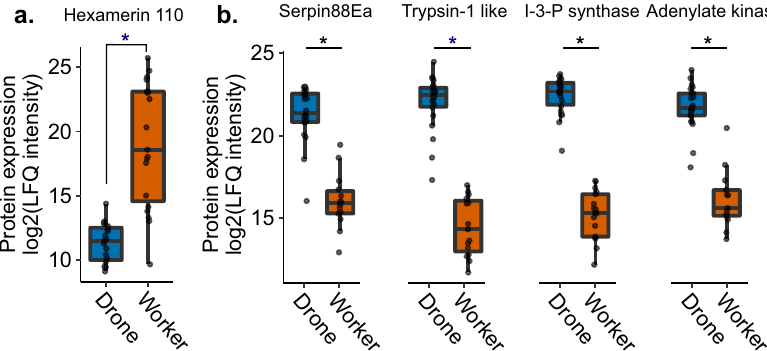
Fig. 5 Expression of the top fi ve most strongly differentially expressed proteins, in terms of fold-change, between drones and workers. Expression of these proteins was not linked to pesticide exposure so the exposure data are included in the drone and worker categories. Asterisks indicate that the comparison was signi fi cant at 5% global FDR (Benjamini – Hochberg). Boxes represent the interquartile range, bars indicate the median, and whiskers span 1.5 times the interquartile range. a Hex110, a conserved amino acid storage protein, was the most strongly differentially expressed protein overall, with very low levels present in the drones. b The top four other proteins were all more abundant in the drones, including a serine protease inhibitor (serpin88Ea), a serine protease (trypsin-1 like), inositol-3-phosphate synthase, and adenylate kinase. Underlying data can be found in Supplementary Data 4, and summary statistics of these data are in Supplementary Data